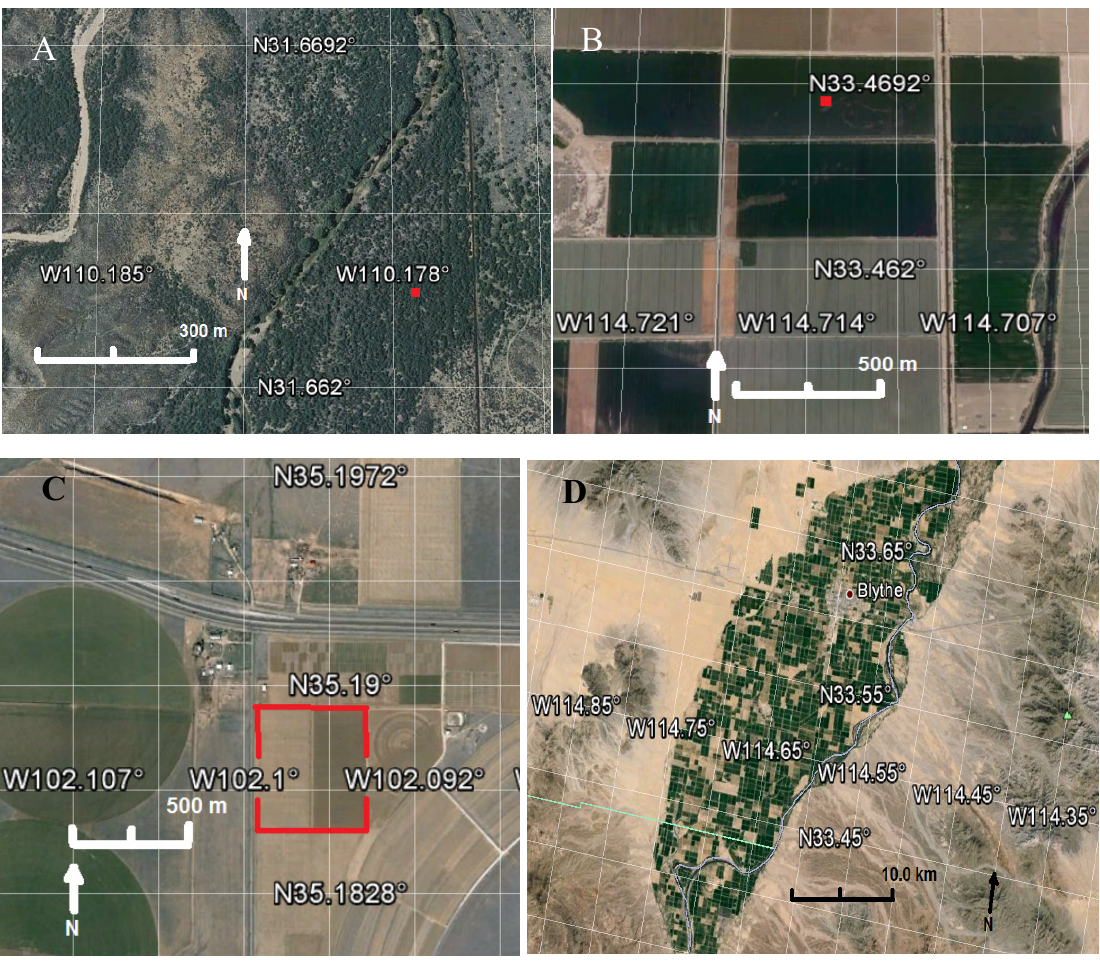
Figure 1. Examples of calibration and validation sites. ( A ) San Pedro River woodland mesquite ( B ) Palo Verde Irrigation District (PVID) alfalfa fields; ( C ) Bushland, TX cotton fields with lysimeters; ( D ) PVID crops; ( E ) La Violada Irrigation District, Spain; ( F ) Cibola National Wildlife Refuge saltcedar. Red squares show location of flux towers (A, B, F) and lysimeters (C). Images from Google